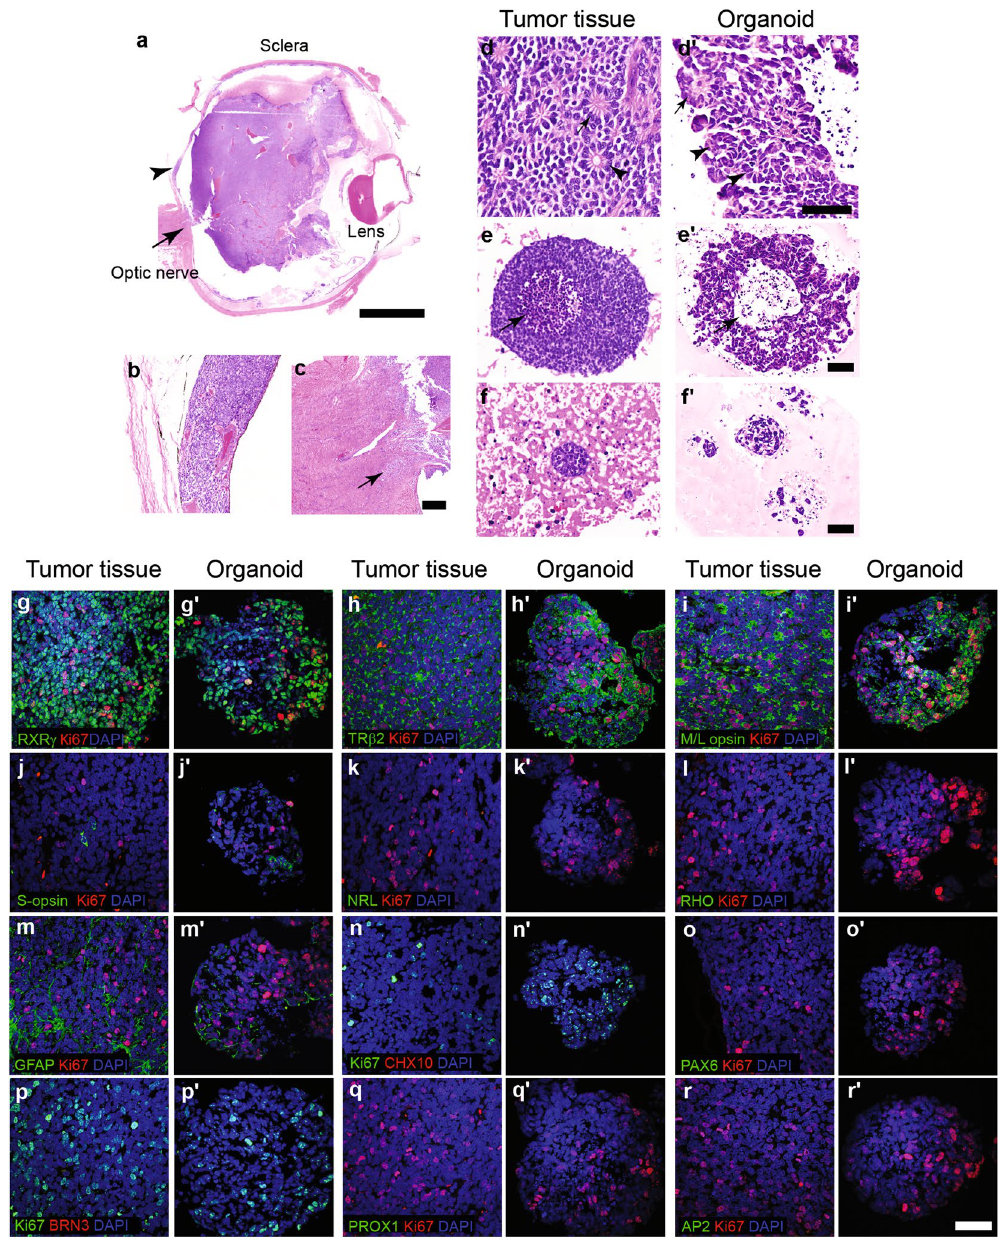
Figure 2. Reproducible cellular features and contents of the retinoblastoma in tumor organoids. ( a–c ) Hematoxylin and eosin staining of the enucleated globe ( a ). Arrow head and arrow in ( a ) indicate magnified regions showing choroid ( b ) and optic nerve (c, (arrow)) invasion, respectively. ( d–f’ ) Representative micrographs indicate histological features of retinal tumor ( d ) and subretinal seeds ( e , f ) in tumor tissue and the corresponding structures in organoids (RB668) ( d’ , e’ , ‘f ). Flexner-Wintersteiner (arrowhead), Homer-Wright (arrow) rosettes ( d , d’ ) and features of tumor seeds, including a large spherical cluster with an outer rim of viable cells surrounding central apoptotic cells (arrow) ( e , e’ ) and a small spherical cluster of viable cells ( f , f’ ) identified in tissue and cultures. ( g–r’ ) Representative micrographs of co-immunostaining indicate the expression of Ki67 and retinal proteins [RXR γ ( g , g ’), TR β 2 (staining specificity demonstrated by Xu et al . 17 ) ( h , h’ ), M/L opsin ( i , i’ ), S- opsin ( j , j’ ), NRL ( k , k’ ), RHO ( l , l’ ), GFAP ( m , m’ ), CHX10 ( n , n’ ), PAX6 ( o , o’ ), BRN3 ( p , p’ ), PROX1 ( q , q’ ), and AP2 ( r , r’ )] in parental tumor tissue and organoids. Nuclei stained by 4 ′ ,6-diamidino-2-phenylindole (DAPI). Scale bar, 5 mm ( a ); 200 µ m ( b , c ); 100 µ m ( d , d’ ) and 50 µ m ( e–f’ and g–o ). See Figs S1 and S2 for other organoid lines (RB654 and